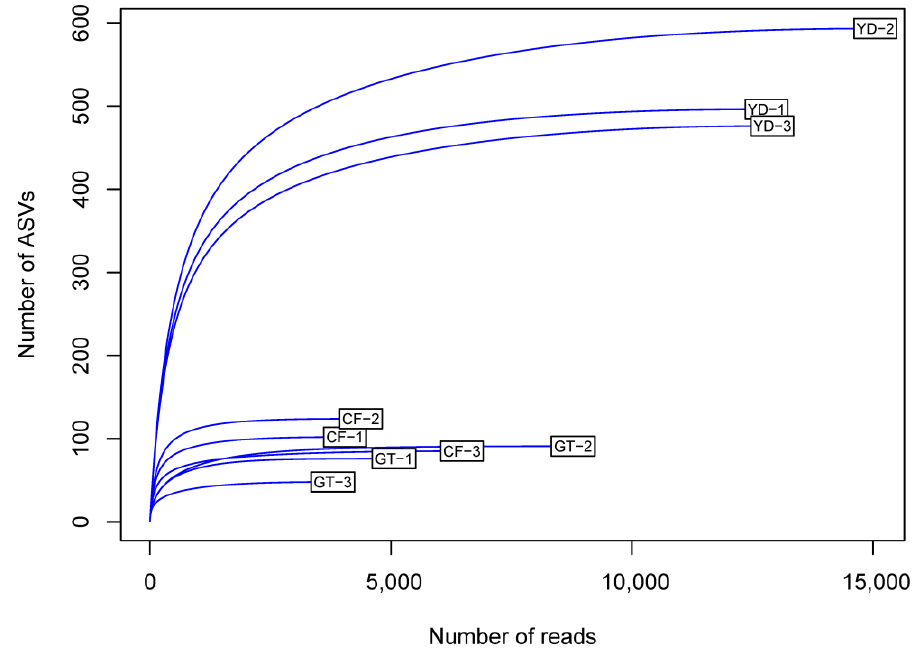
Figure 1. Rarefaction curves for the chironomid samples (GT and CF) and the filter samples (YD). GT: G. to-kunagai; CF: C. flaviplumus; YD: Yeon Deung water.